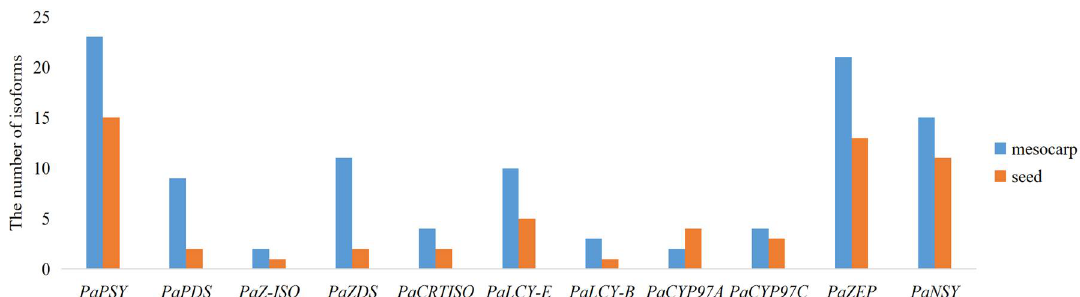
Figure 6. Number of single-molecule real-time (SMRT) isoforms corresponding to the putative 11 genes in the carotenoid biosynthetic pathway.